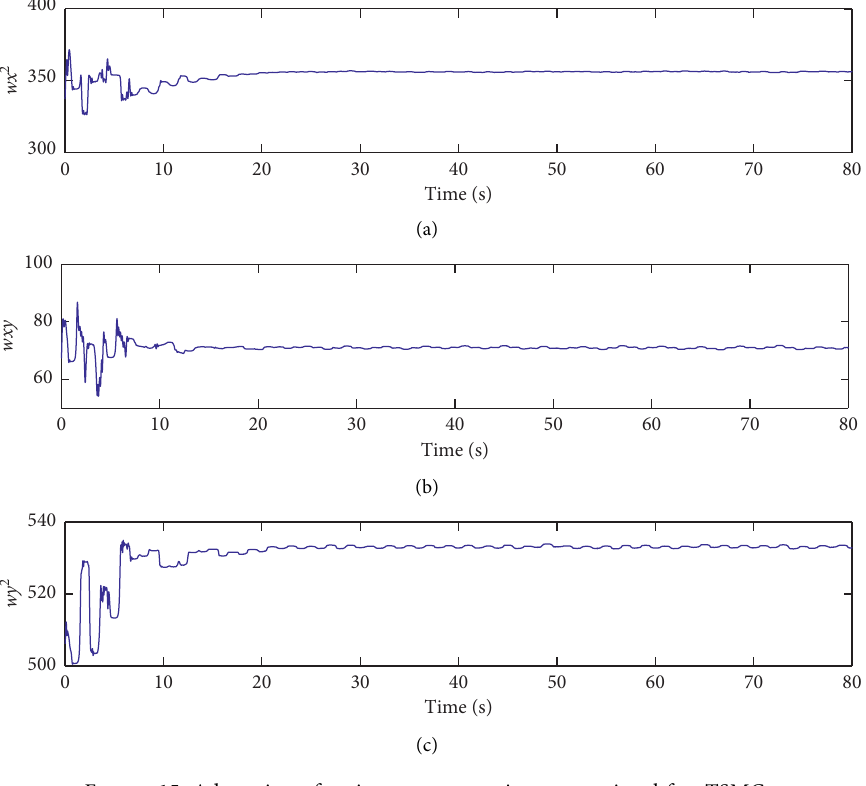
Figure 15: Adaptation of spring constants using conventional fast TSMC.